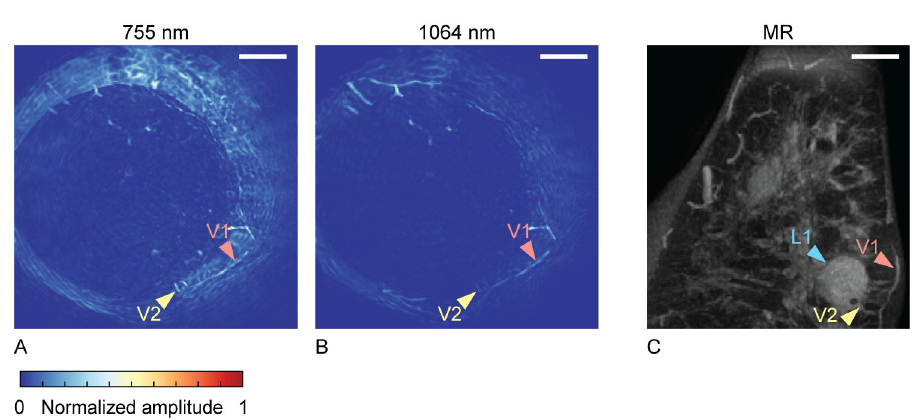
Fig 10. Case 4: Local MIPs of slabs with a thickness of 15 mm, near the main lesion, close to the chest wall, in the coronal view. Photoacoustic images at 755 nm (A) and 1064 nm (B), compared to a post-contrast dynamic T1 MR image (C). All scale bars represent 20